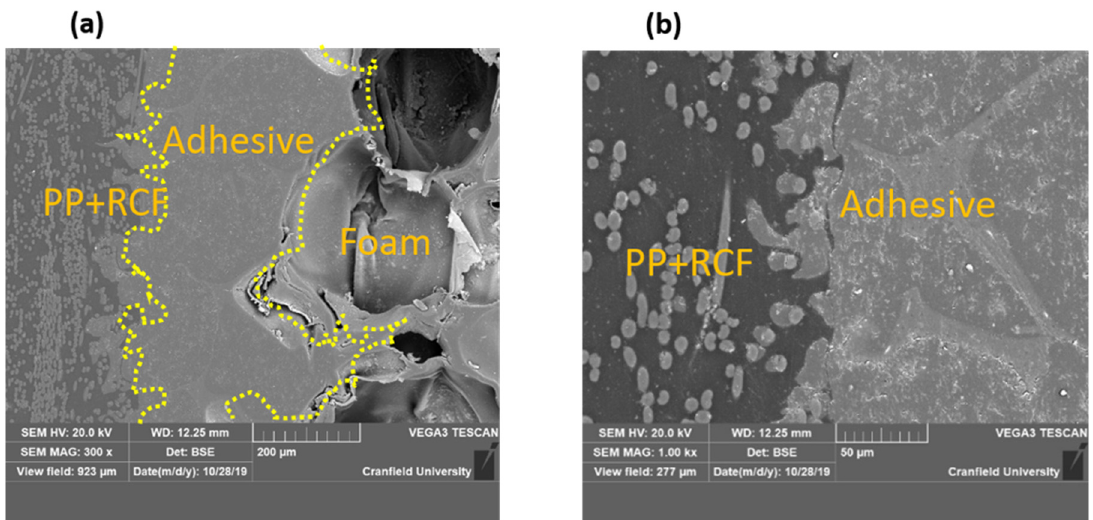
Figure 4. ( a ) Adhesive region of pure RCF sample. ( b ) Magnified image.